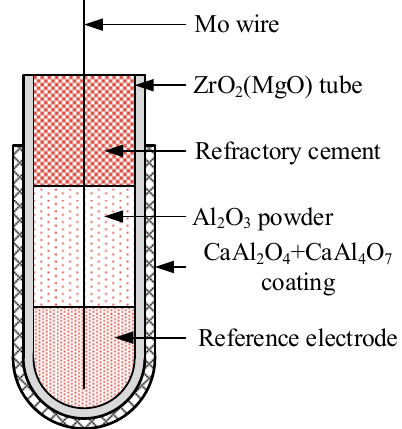
Figure 1. Schematic drawing of the assembled sulfur sensor.